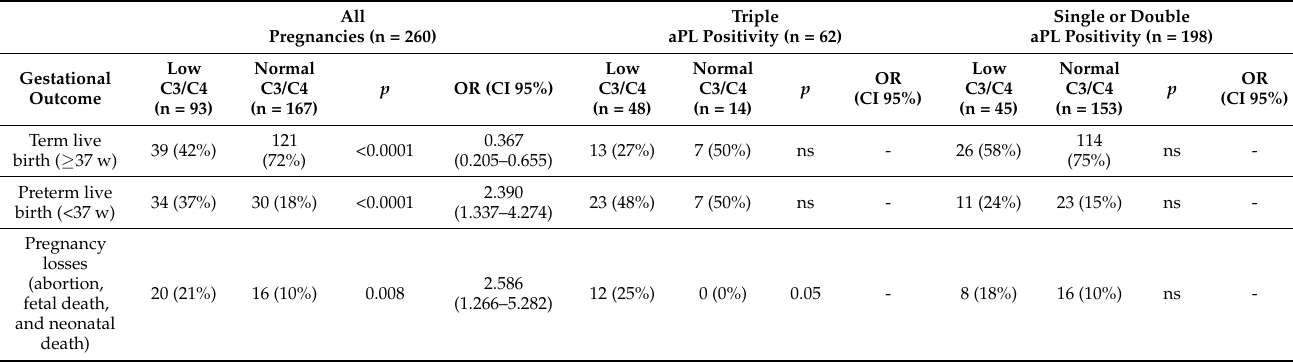
Table 2. Relationship between gestational outcome, maternal pregnancy complications and preconception complement levels. All Pregnancies (n = 260)